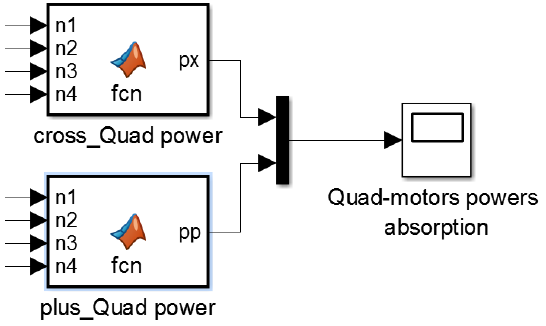
Figure 10. The designedSimulink calculates and compares the energy consumed for each